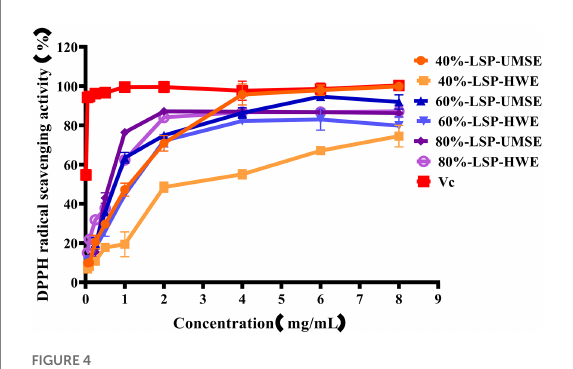
FIGURE 4 Scavenging ability of LSP-UMSE and LSP-HWE against 2,2-diphenyl-1-picrylhydrazyl (DPPH) radicals. Each value is expressed as mean ± SEM ( n =